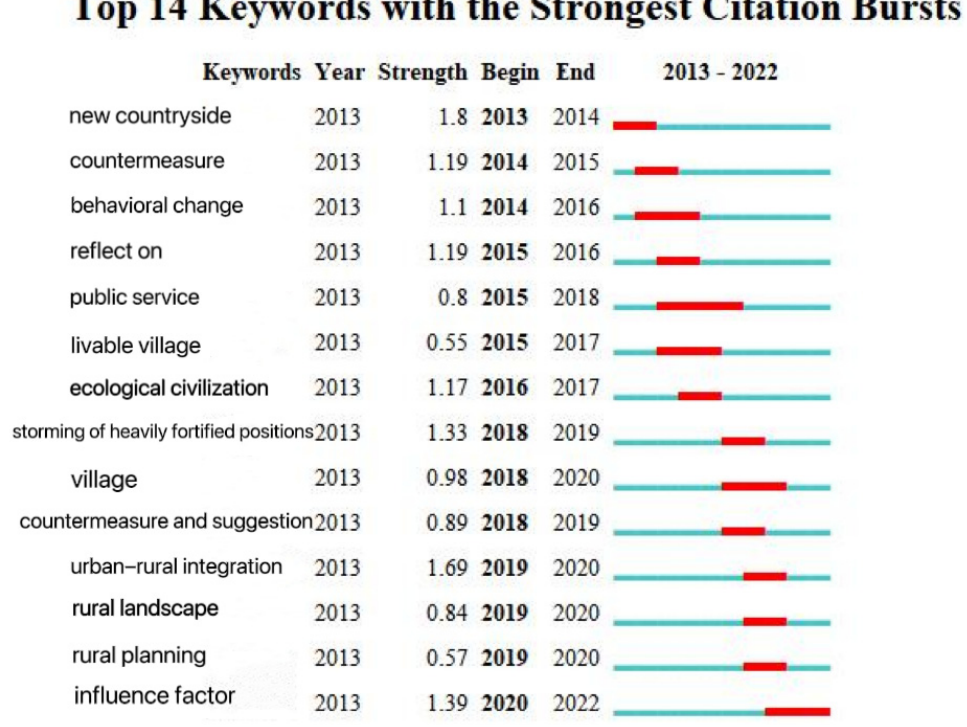
Figure 9. Timeline of keywords in rural human settlements research.